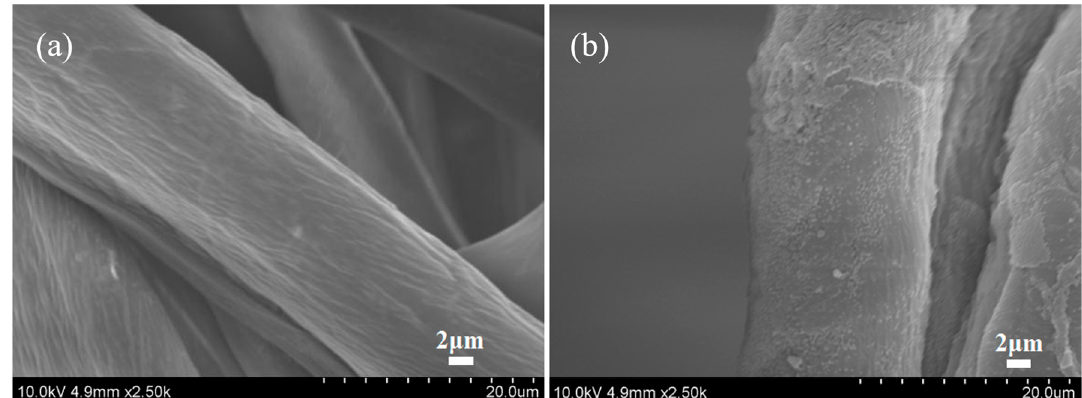
Figure 9. SEM images of untreated cotton fabrics ( a ) and treated cotton fabrics ( b ).